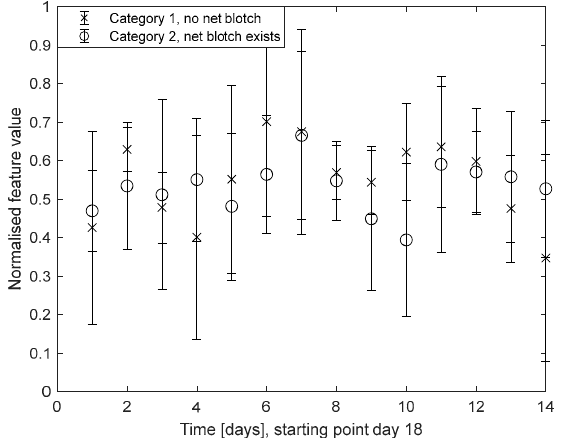
Figure 12. The mean D sn values and their standard deviations with Categories 1 and 2 data sets applying the best feature (Equation (3)) and starting the analysis on day 18 from the beginning of the growing season.